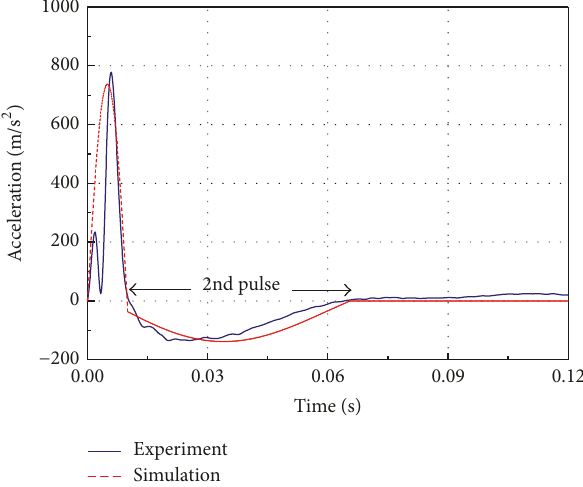
Figure 9: Damping force versus piston velocity.